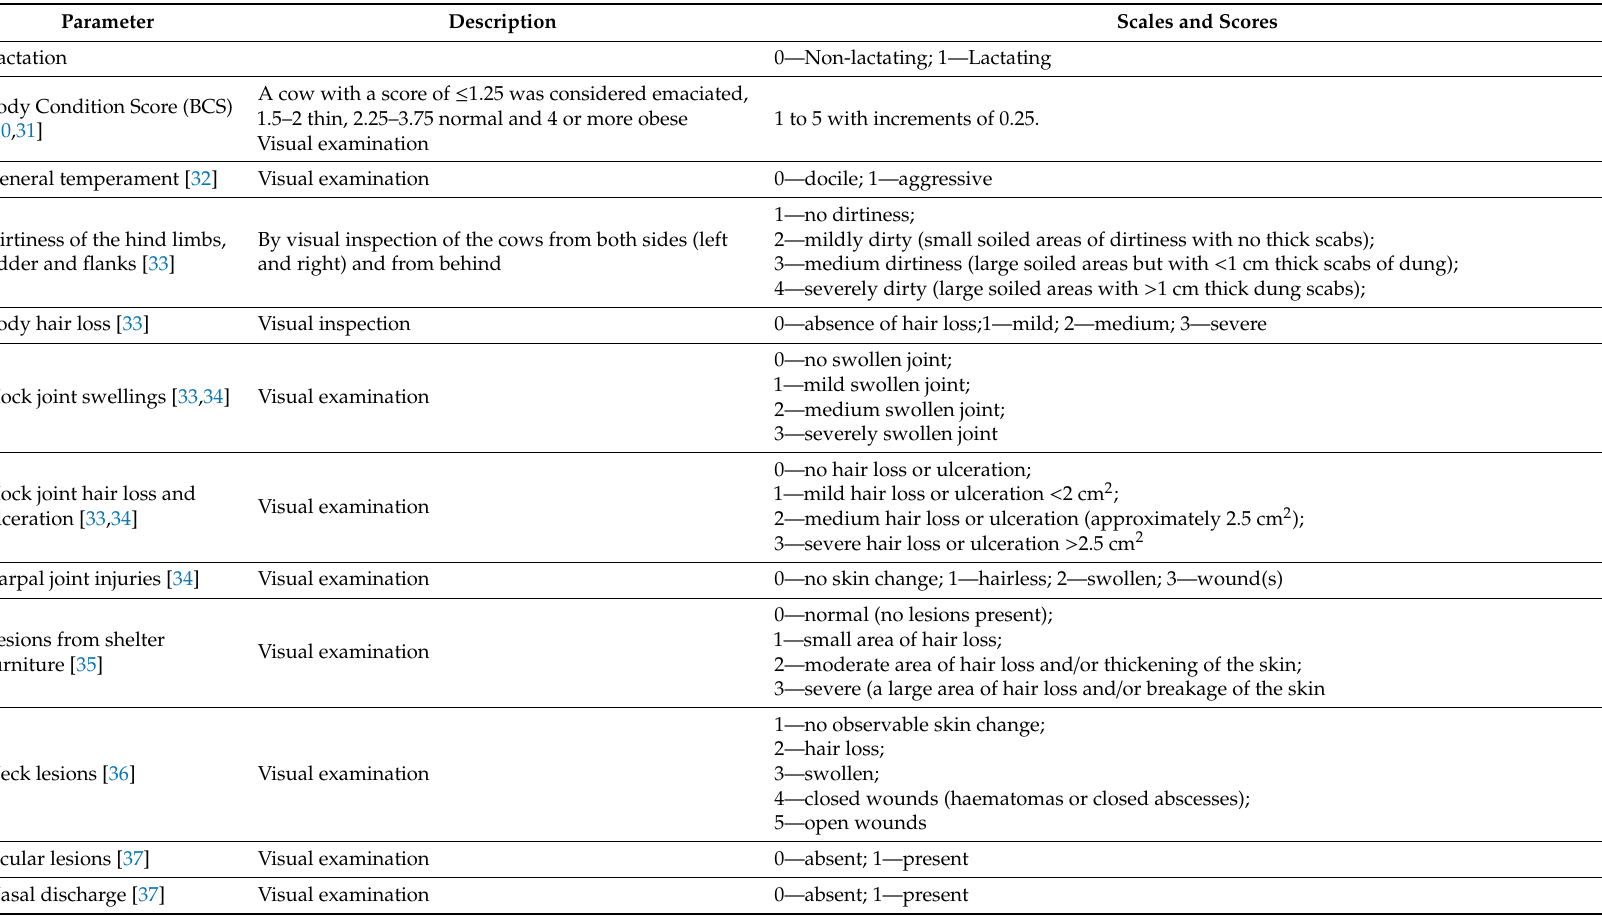
Table A1. Cow-based parameters used for the assessment of the welfare of cows in